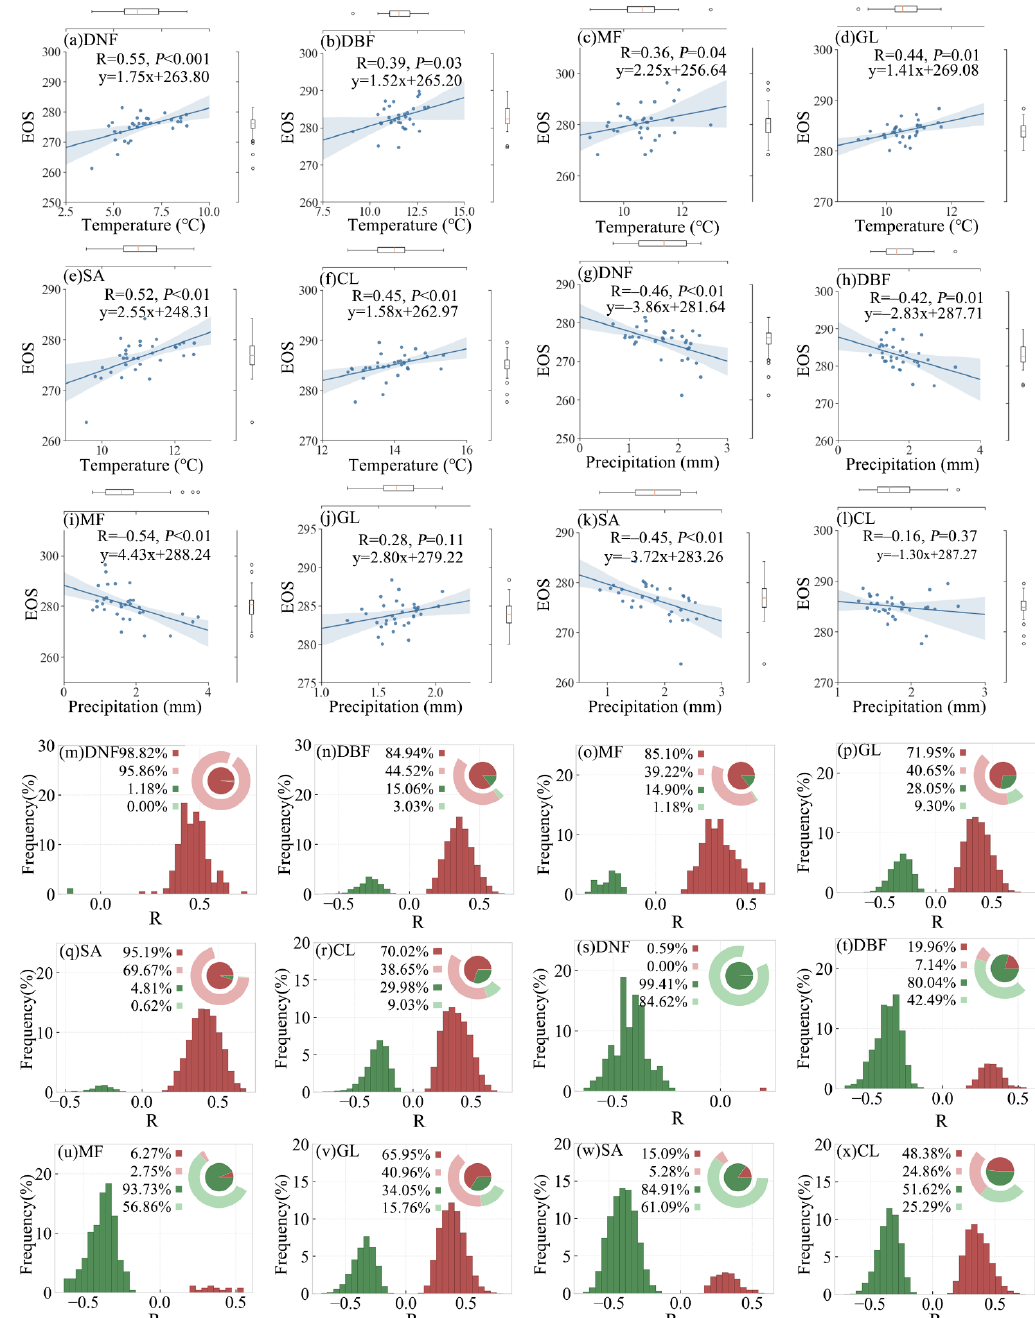
Figure 9. Partial correlogram between preseason temperature ( a – f )/precipitation ( g – l ) and EOS for the various vegetation types, including DNF (deciduous needle leaf forest), DBF (deciduous broadleaf forest), MF (mixed forest), GL (grassland), SA (savanna), CL (cropland). Frequency distribution (%) of the areas with various R values between EOS and preseason temperature ( m – r )/precipitation ( s – x ) for the six vegetation types.